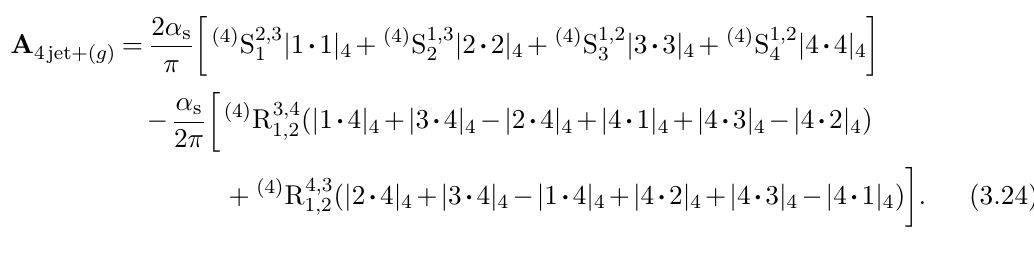
(cid:12) (cid:11) (cid:12) (cid:12) M 4jet+( g ) (cid:12) 1 || 4